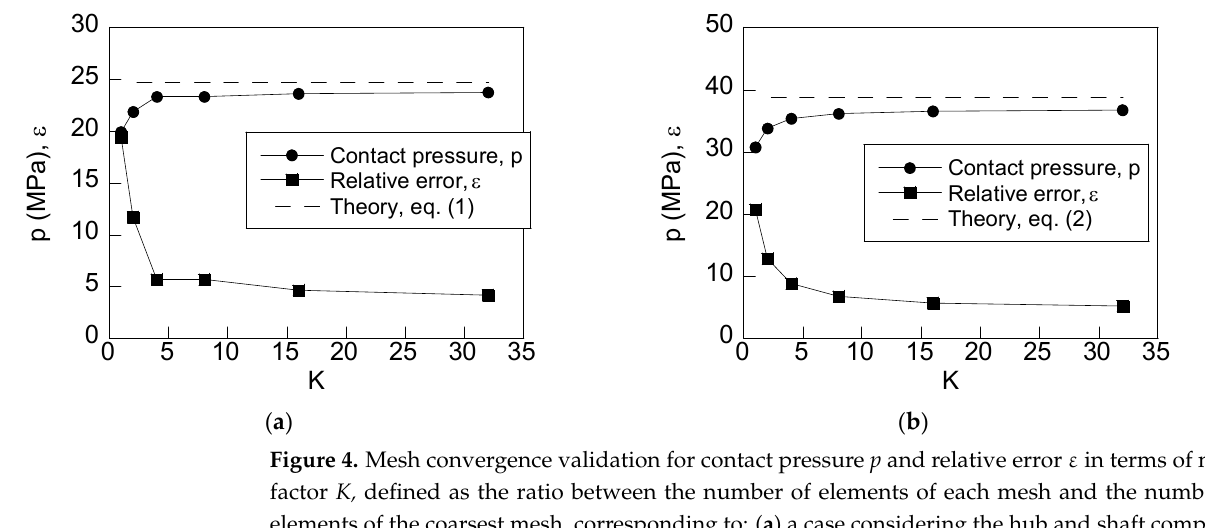
Figure 4. Mesh convergence validation for contact pressure p and relative error ε in terms of mesh factor K, defined as the ratio between the number of elements of each mesh and the number of elements of the coarsest mesh, corresponding to: ( a ) a case considering the hub and shaft composed of the same material and ( b ) a case considering the hub and shaft composed of different materials.